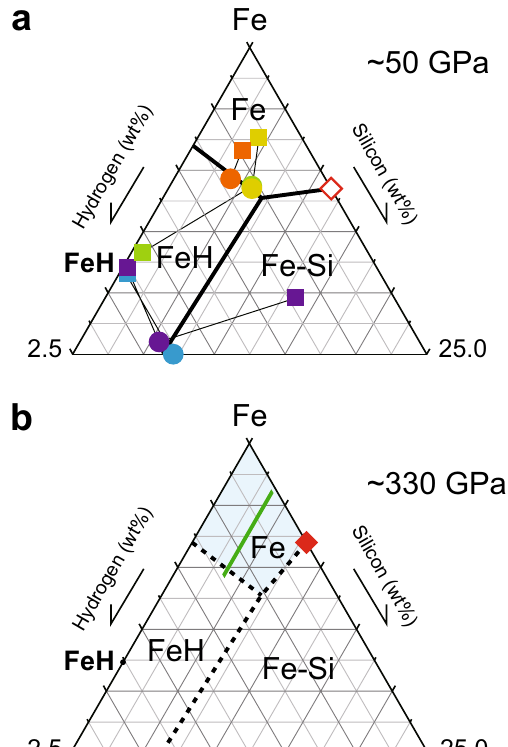
Figure 3. Liquidus phase relations in Fe–Si–H showing the liquidus fields of hcp Fe, fcc FeH and B2 Fe–Si at ( a ) ~ 50 GPa and ( b ) ~ 330 GPa. The compositions of liquids (circles) and coexisting solid phases (squares) obtained in the present experiments are plotted in ( a ); orange, run #1; yellow, run #2; green, run #3; purple, run #4; blue, run #5. Open and closed red diamonds in ( a ) and ( b ) show the Fe–FeSi eutectic liquid composition at respective pressure 22 . The liquid core compositions (green belt), calculated with D Si and D H considering their uncertainties from the proposed inner core solid compositions 17 , are mostly within the liquidus field of (Si, H)-bearing hcp Fe (blue area) at 330 GPa ( b ). Note that stochiometric FeSi includes 33.5 wt%